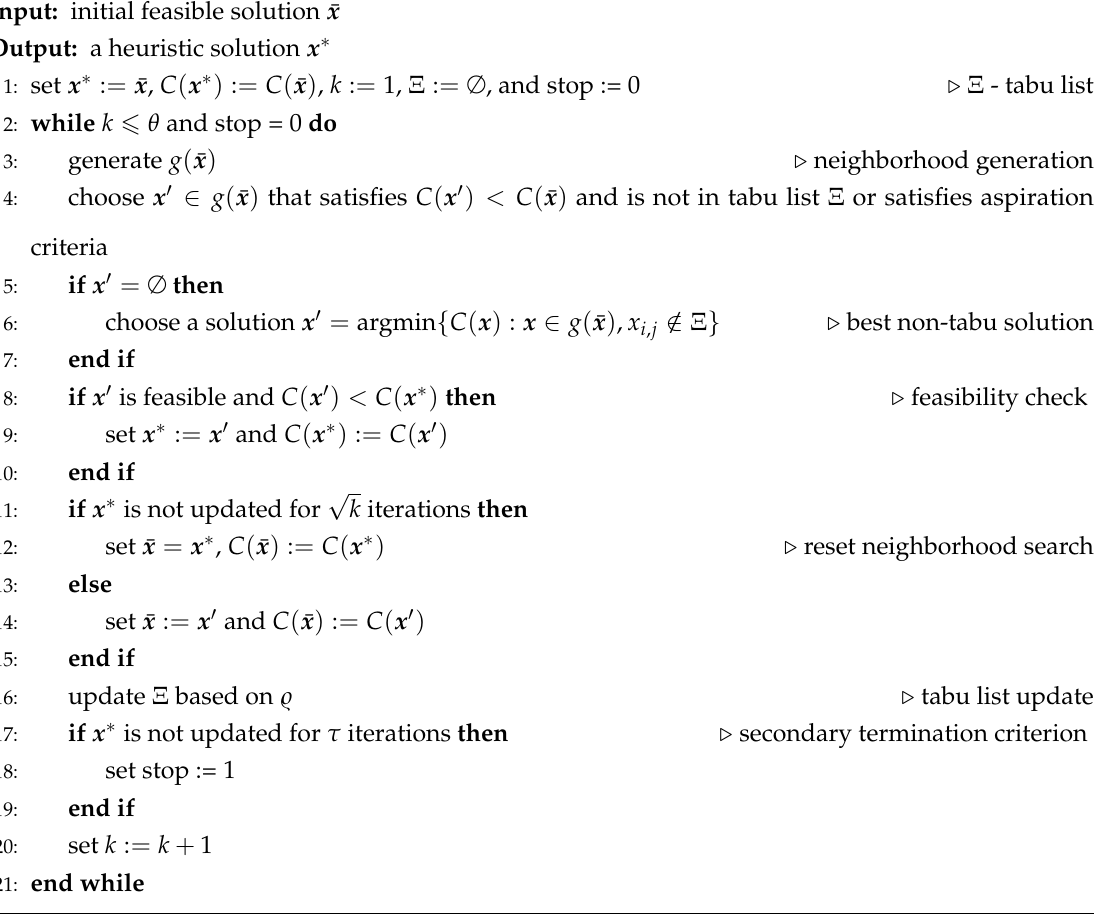
Algorithm 2 Tabu search